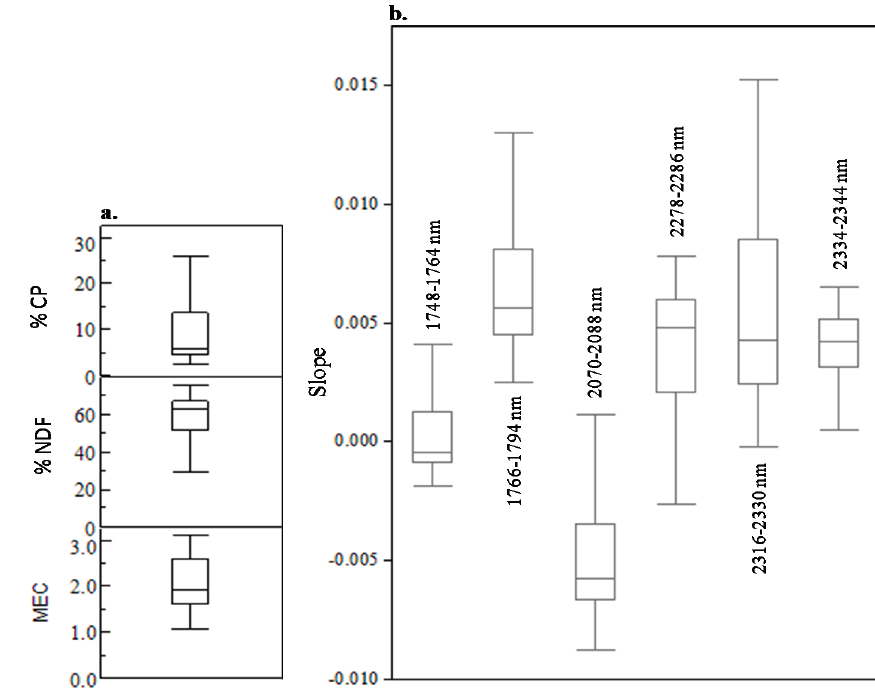
Figure 2. Distribution of ( a ) CP, neutral detergent fiber (NDF), metabolic energy concentration (MEC) and ( b ) slope values for six spectral